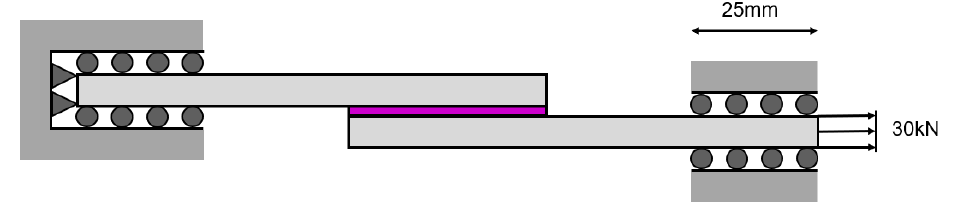
Figure 7. Boundary conditions considered in the SLJ.